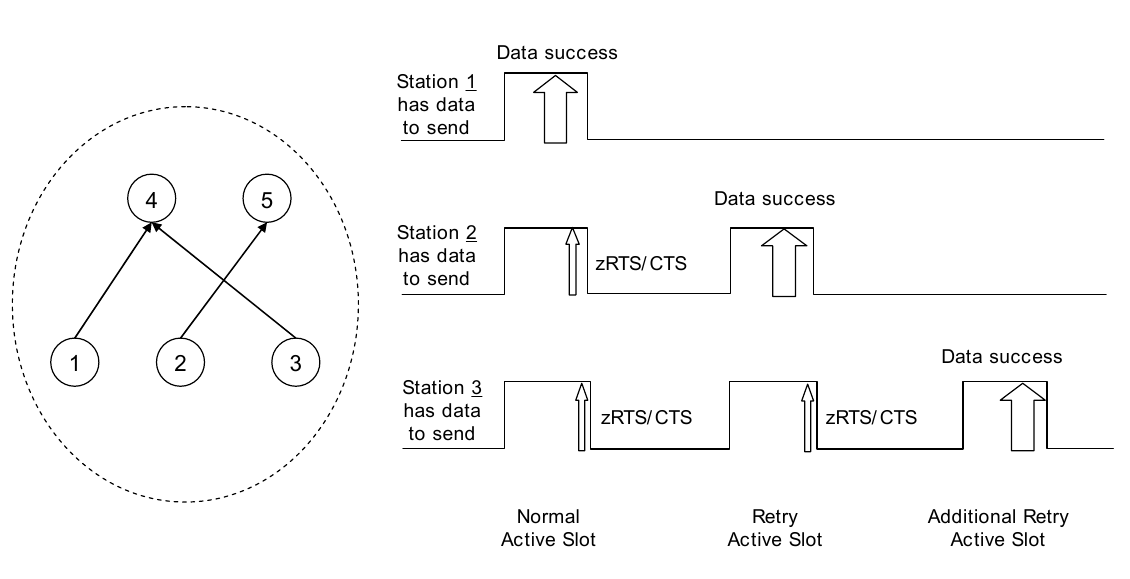
Figure 3. Reservation and retrying procedure between parents and child nodes using zero RTS frame.